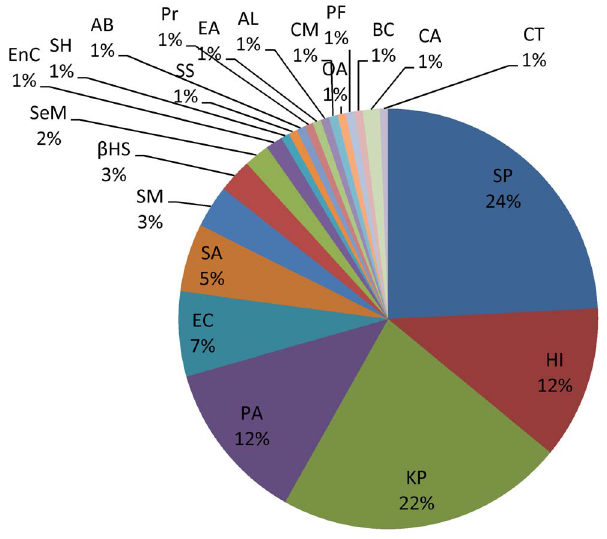
Figure 2. Etiological distribution of fever and respiratory syndrome in Guangxi, China, 2009–2011. Of 153 etiologies cultured from specimens of fever and respiratory syndromes: Strepto- coccus pneumonia (SP, 37 strains), Haemophilus influenza (HI,18), Klebsi- ella pneumonia (KP,34), Pseudomonas aeruginosa (PA,19), Escherichia coli (EC, 10), Staphylococcus aureus (SA,8), Stenotrophomonas maltophi- lia (SM,5), b -hemolytic streptococcus ( b HS,4), Serratia marcescens (SeM,3), Enterobacter cloacae (EnC,2), Staphylococcus hominis (SH,1), Staphylococ- cus saprophyticus (SS,1), Acinetobacter baumannii (AB,1), Proteus(Pr,1), Enterobacter aerogenes (EA,1), Acinetobacter lwoffii (AL,1), Chryseobacter- ium meningosepticum (CM,1), Ochrobactrum anthropic (OA,1), Pseudomo- nas fluorescens (PF,1), Burkholderia cepacia (BC,1), Candida albicans (CA,2), Candida tropicalis (CT,1).